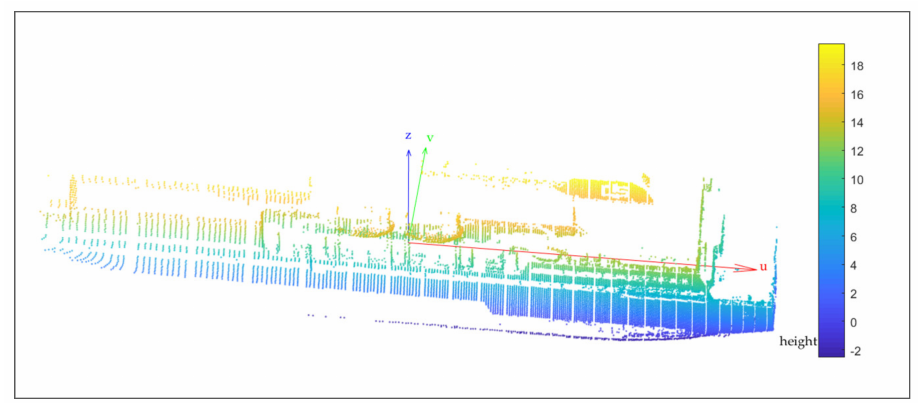
Figure 13. Ship’s heading calculation.